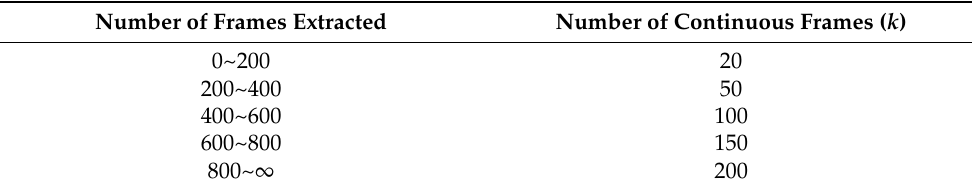
Table 2. Frame continuity unit according to the number of frames of a video in comparison. Number of Frames Extracted Number of Continuous Frames ( k